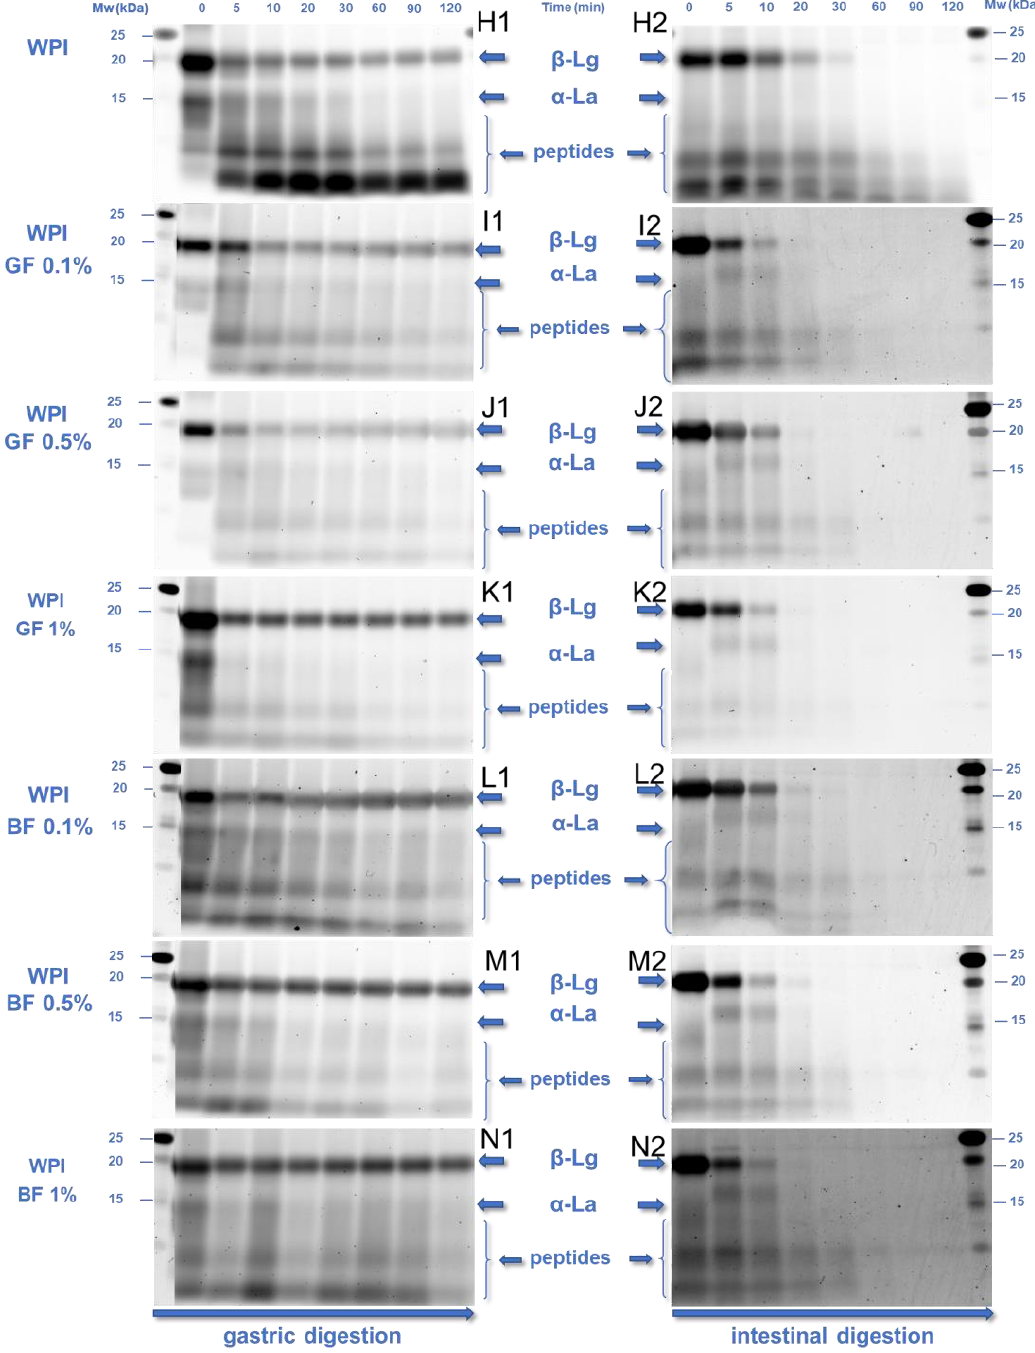
Figure 7. SDS-PAGE electropherogram of the gastric ( 1 ) and intestinal ( 2 ) phases of the NaCN-( A – G ) and WPI-( H – N ) based food models as influenced by the phenotype and concentration (0.1–1% wt.) of flaxseed gum. An SDS-PAGE analysis was conducted on gastric and intestine aliquots sampled at predetermined time points (0, 5, 10, 20, 30, 60, 90, and 120 min). Abbreviations used: β -Lg: β - lactoglobulin, α - La: α -lactalbumin.